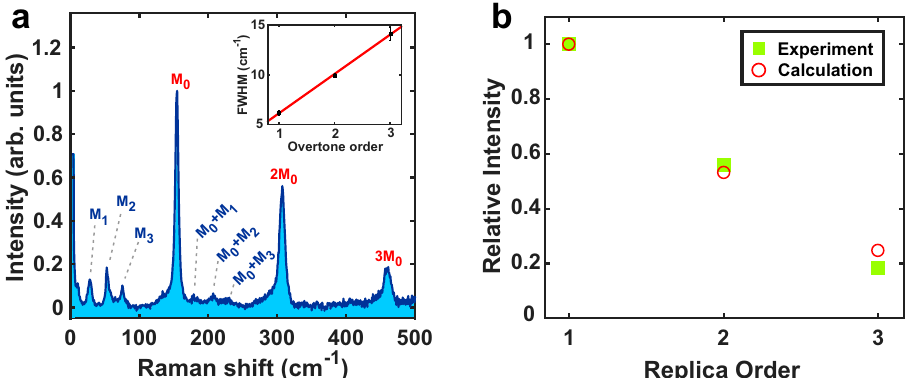
Fig. 1 MPRS results for CsPbBr 3 nanocrstals (NCs). a MPRS spectrum of CsPbBr 3 NCs at 3.8 K. The labels represent the different phonon modes observed and their combinations. The inset shows an increase of the FWHM for consecutive overtones. The FWHM values and their respective errorbars were obtained via Gaussian fi tting of each peak. The red line is a guide to the eye. b Experimental and calculated intensities of the M 0 replicas in a . Calculations ¼ 2 : 375 eV. The maximum relative measurement error corresponds to the third-order replica, and is assume S = 0.39, σ = 32.5 meV, Γ 0 = 1 meV, and E 0 g around 10%, due to the subtraction of the PL background. The sum of squared residuals for the fi t is